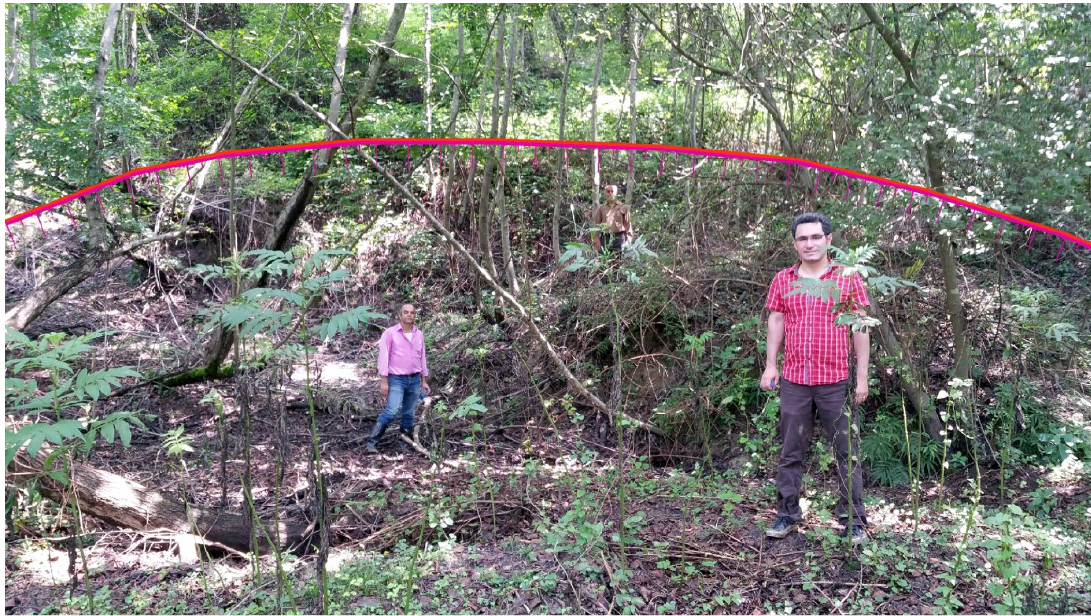
Figure 7. Ground picture of one of the scarps (red line) observed in the landslide detected by ALOS data